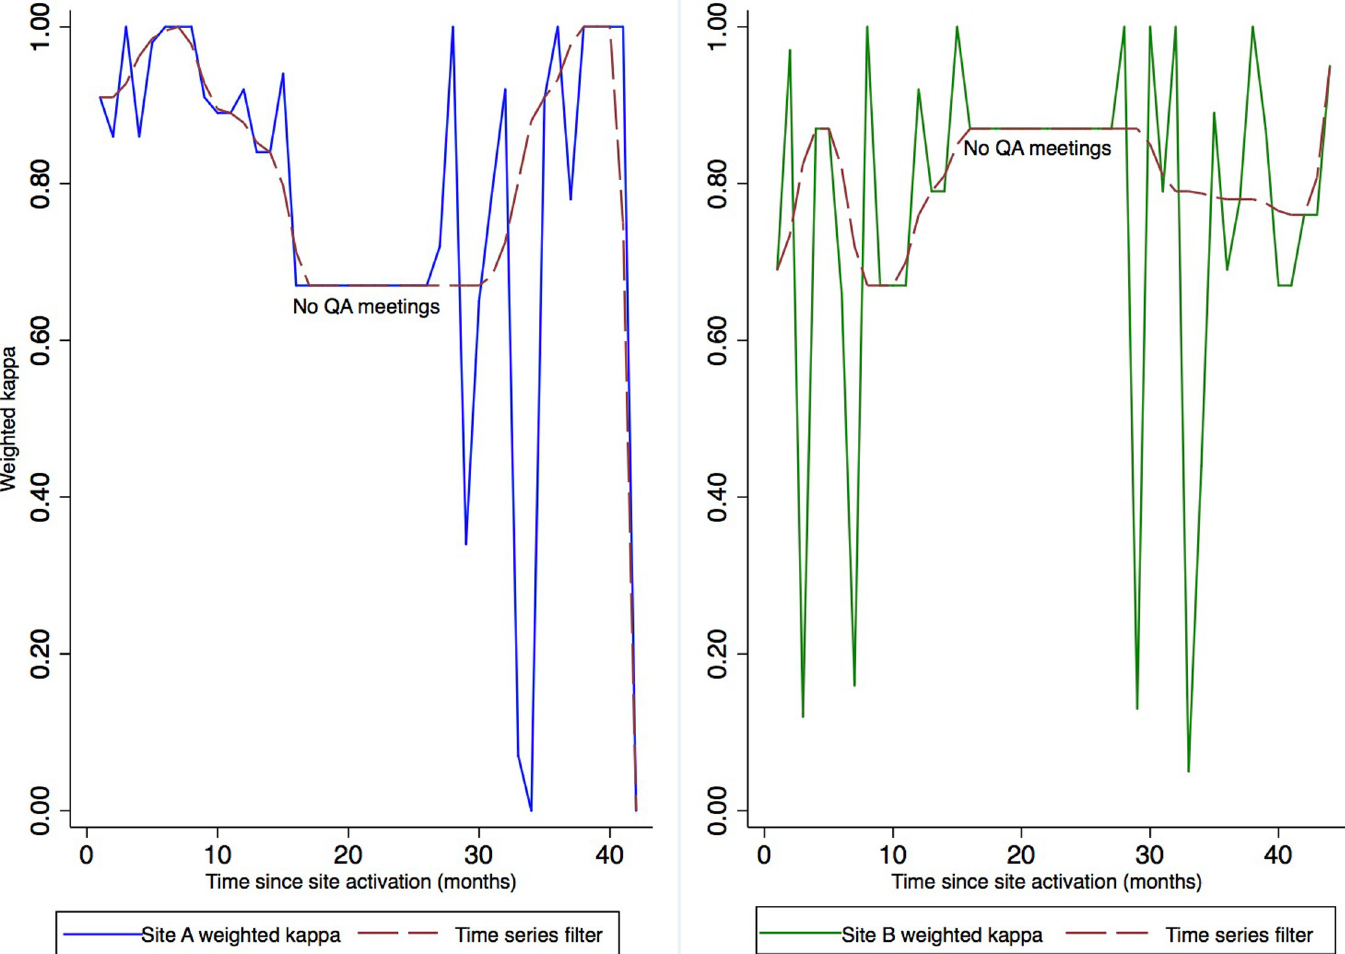
Fig 3. Variability in monthly weighted kappa statistic for Sites A and B: 2012–2014. Weighted kappa estimates for Site A were highly variable, with no correlations over time, indicating that results for each month were random and independent of results from previous months. In Site B, monthly weighted kappa estimates demonstrated an autoregressive behavior such that an estimate above the mean in month (t-1) was followed by an estimate below the mean in the next month (t) .